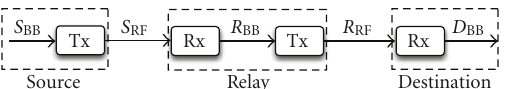
Figure 2: Tx and Rx models.